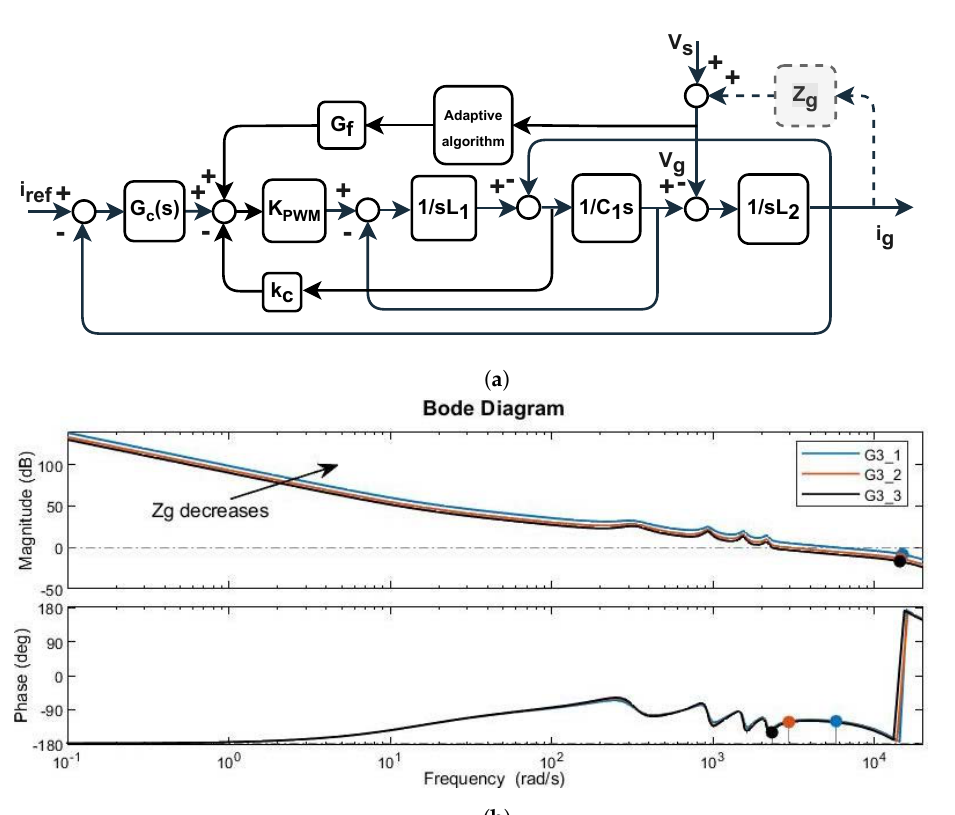
Figure 5. Strategy 3: Adaptive grid voltage feedforward ( a ) Average switch control model. ( b ) Open loop system